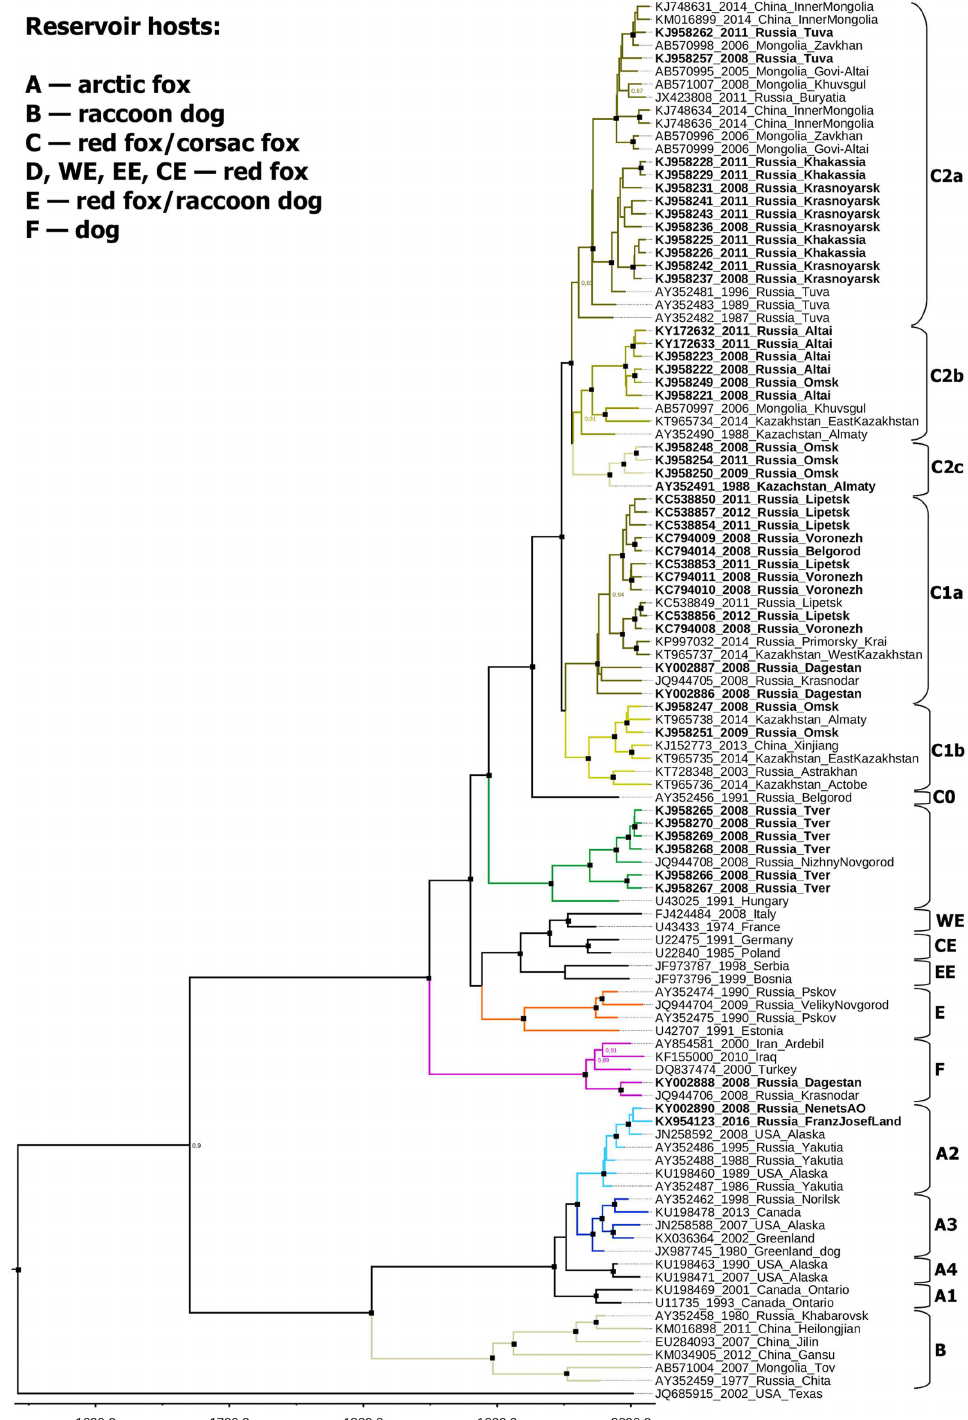
Fig 1. Bayesianphylogenetic analysis of near-complete N-gene sequences of the rabies virus strains circulating in the Russian Federation. Scale bar shows time in years. Branchesare color-codedaccordingto describedgroups. Node posterior probabilities above 95% are shown by black squaresat the relevant nodes. Posterior probabilities between80–95%are indicatedby numbers. Posterior probabilities below80% are not indicated. Sequences obtainedin the current study are shown in